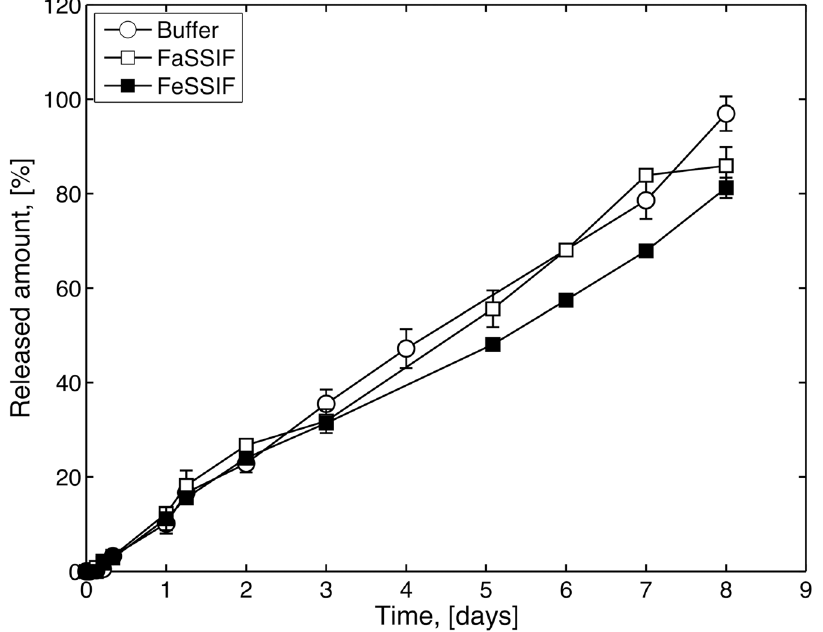
Fig 7. Release of griseofulvin from tablets containing SDS (Formulation 2) in buffer buffer (open circles), FaSSIF (open square) and FeSSIF (filled square). Error bars represent standard deviation (n = 2).